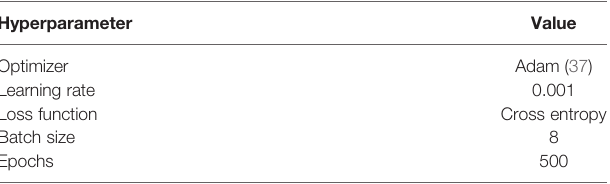
TABLE 1 | The hyperparameters of the DBNN